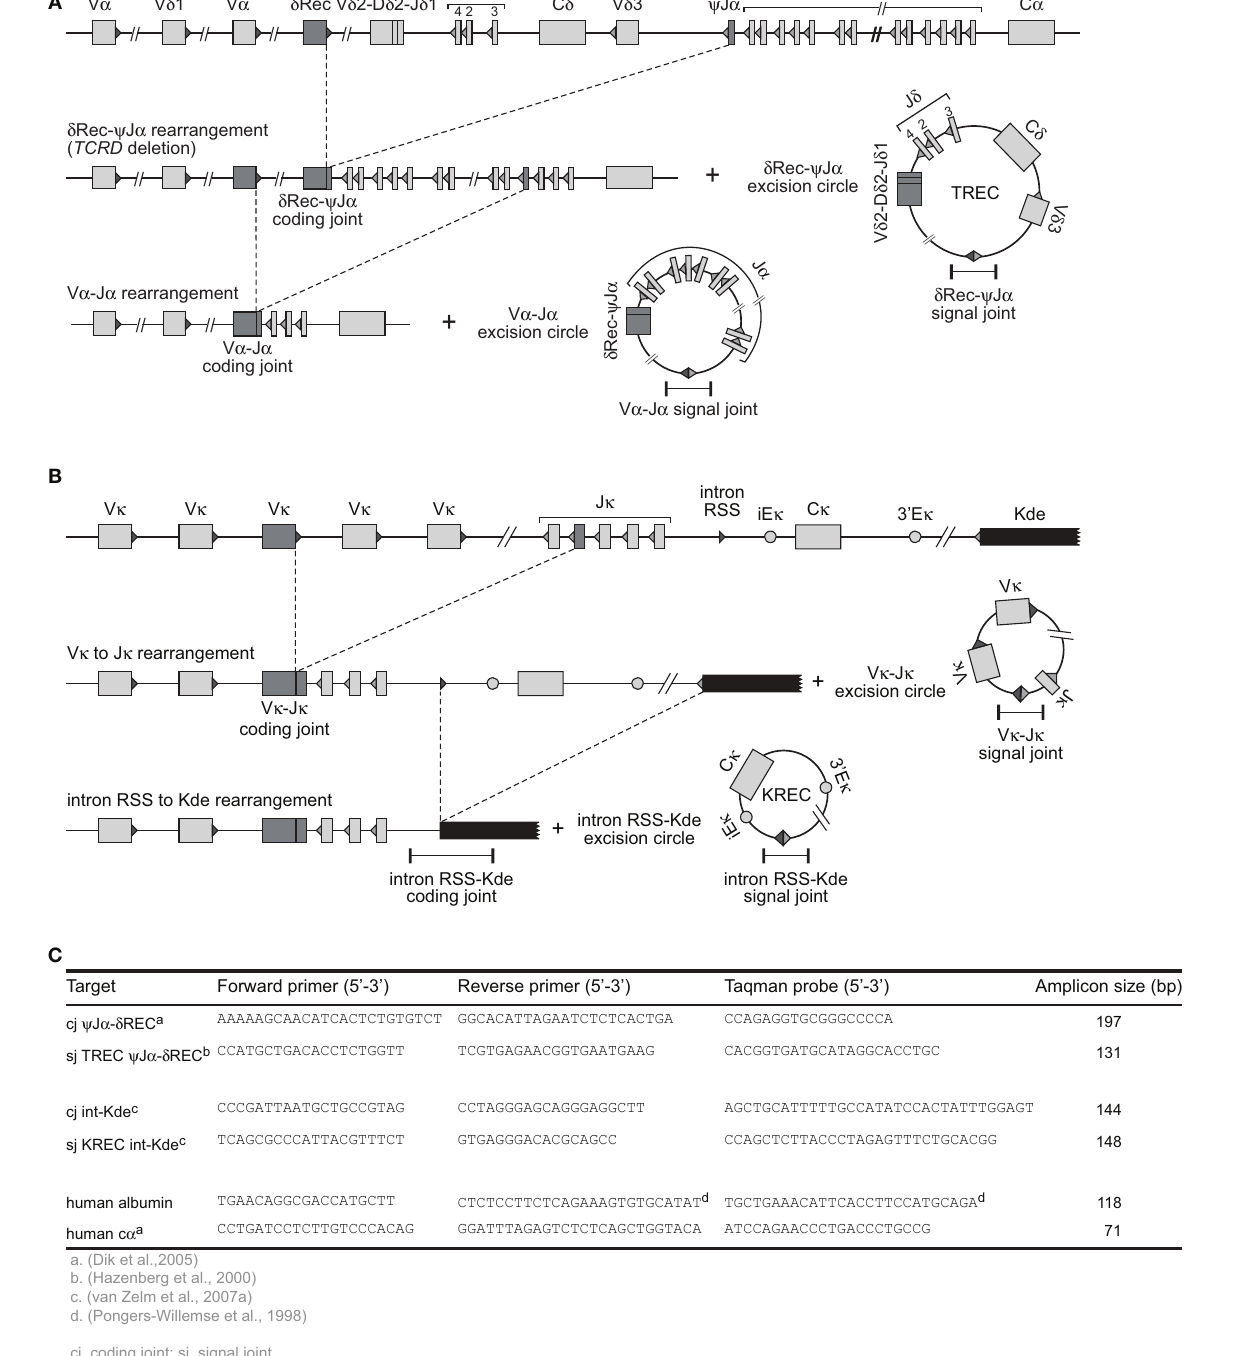
FIGURE 2 |V(D)J recombination and the formation of excision circles. (A) Sequential rearrangements in theTCRAD locus. FollowingV(D)J recombination ofTCRD, the whole locus is then preferentially deleted by δ REC– ψ J α rearrangements in the αβ + T-cell lineage.This gives rise to a δ REC– ψ J α signal joint on an excision circle (TREC) and a δ REC– ψ J α coding joint in the genome.The coding joint is deleted from the genome byTCRA (V α -J α ) rearrangements and is then located on aTREC as well. (B) V(D)J recombination on the IGK locus results in aVJ κ coding joint. Subsequent